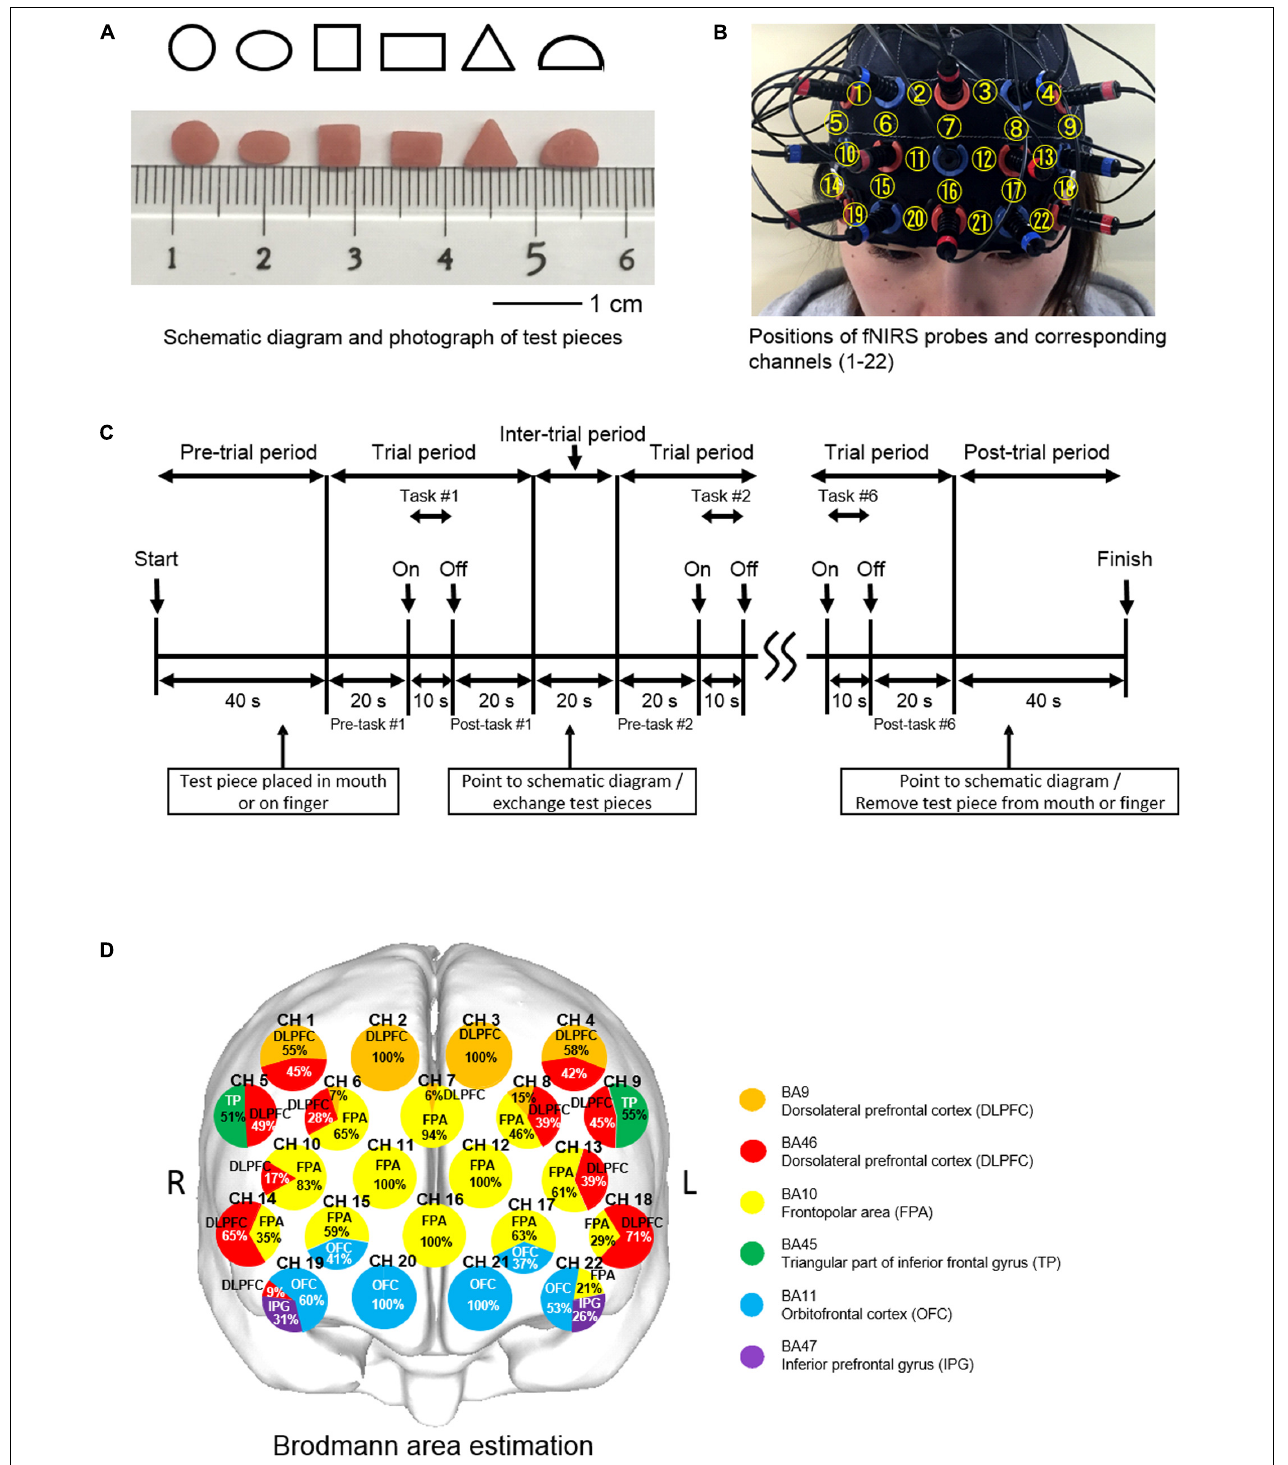
FIGURE 1 | Experimental aspects of finger and oral shape discrimination using prefrontal functional near-infrared spectroscopy (fNIRS). (A) Schematic diagrams and photographs of six types of test pieces: circle, ellipse, square, rectangle, triangle, and semicircle. (B) Positioning of the prefrontal fNIRS probes and corresponding channel numbers. (C) Timeline of a single session composed of six trials of shape discrimination in 8 min. (D) Location of the prefrontal fNIRS channels. Orange and red indicate the dorsolateral prefrontal cortex ( DLPFC ); yellow , the frontopolar area ( FPA ); green , triangular part of the inferior frontal gyrus ( TP ); blue , the orbitofrontal cortex ( OFC ); and purple , the inferior prefrontal gyrus ( IFG ). Each circle corresponds to a channel number. Pie chart shows percentage in cortical areas.